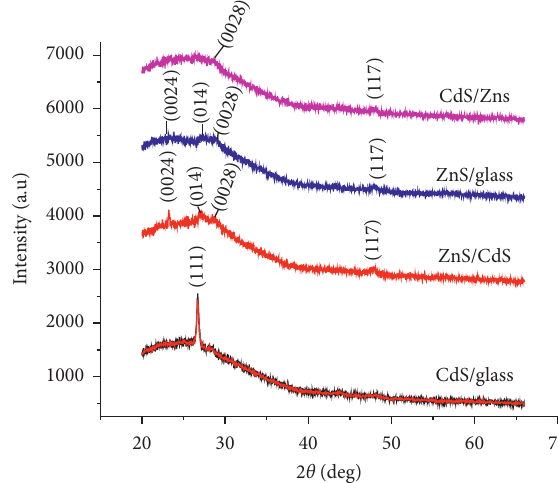
Figure 1: XRD patterns of CdS, ZnS, CdS/ZnS, and ZnS/CdS thin